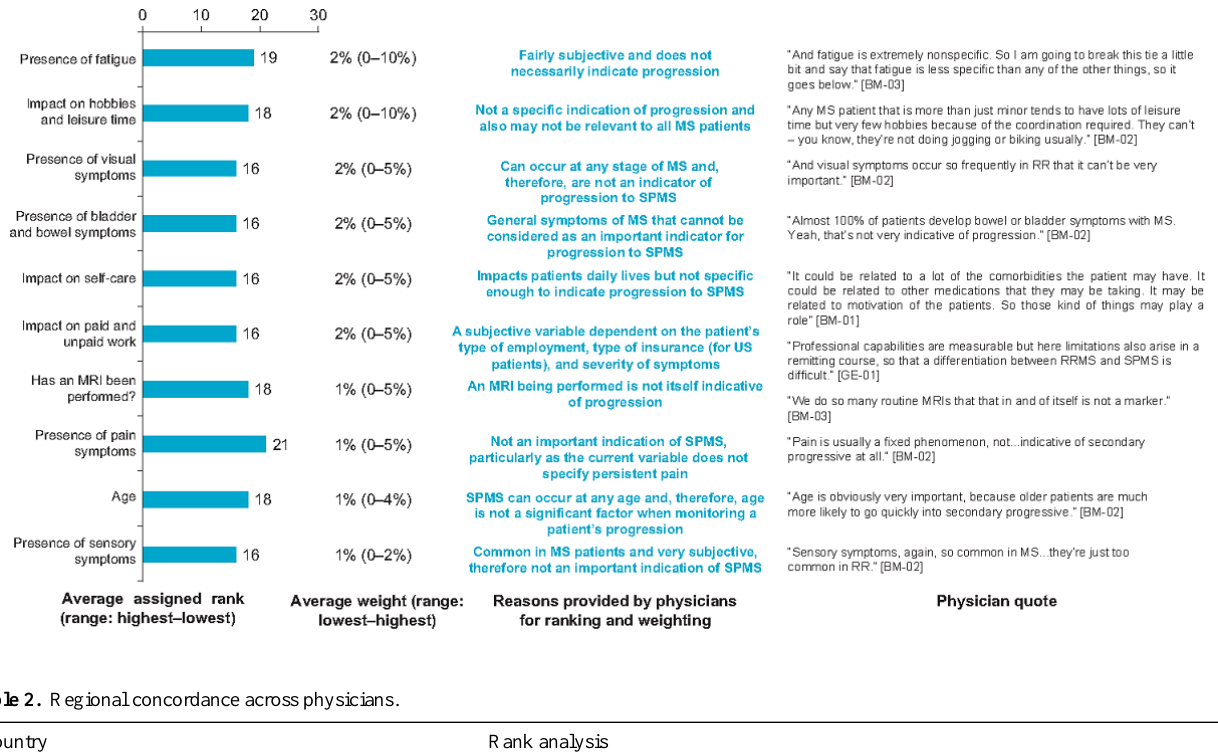
Figure 6. Variables of low importance in progression to secondary progressive multiple sclerosis. Ranking out of 26 variables included. Lower ranking indicates greater importance. SPMS: secondary progressive multiple sclerosis.